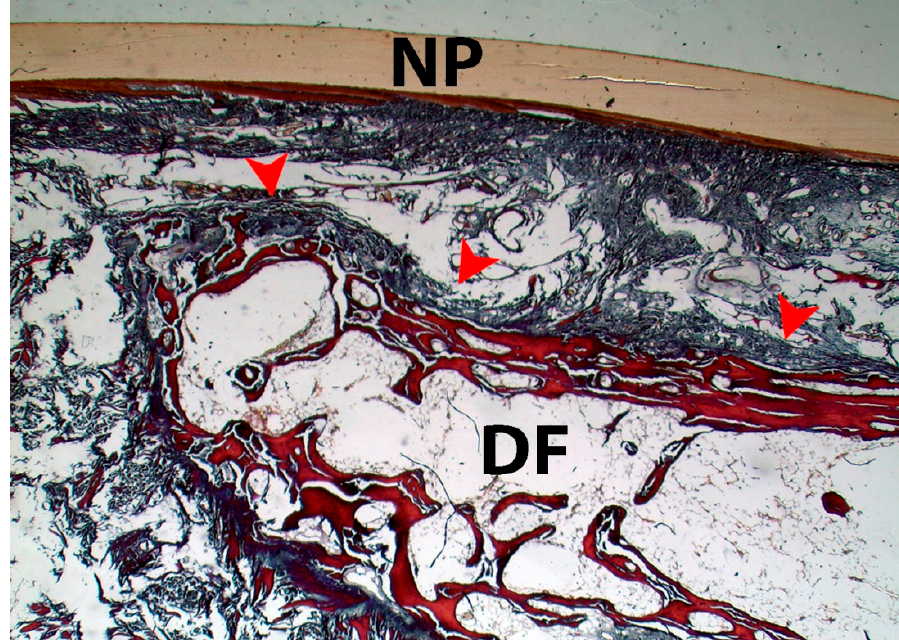
Figure 5. High-power magnification of the red squared area of Figure 4. The superficial EPL tendon bundle attached to the distal phalanx of the thumb (arrowheads). NP—nail plate; DF—distal phalanx. (10× magnification). Tetrachrome VOF-III GS stain (light green SF/or fast green FCF, methyl blue, Orange G, and acid fuchsin).